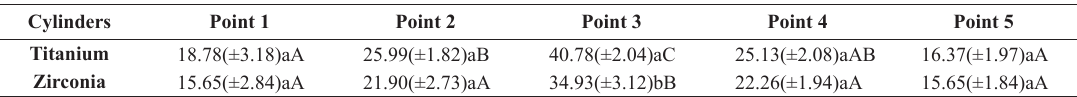
Table 2. Comparison of mean stress (standard deviation) (MPa) for titanium and zirconia implants (2-way ANOVA, Bonferroni, (p < .05). Cylinders